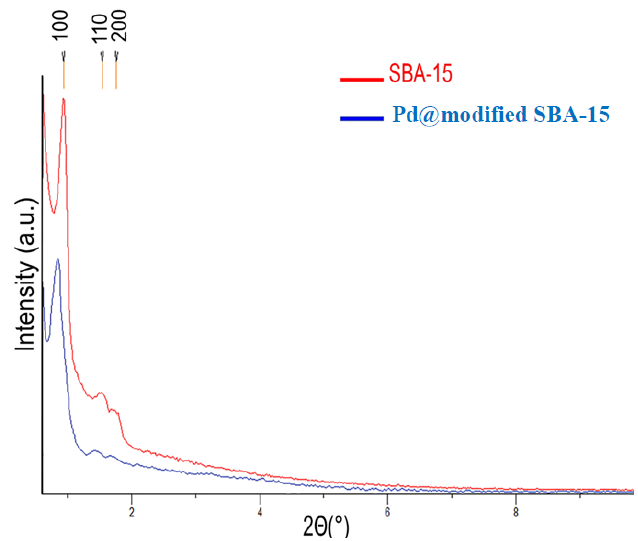
Fig. 2. The XRD pattern of SBA-15 and Pd@modified Figure 2 : The XRD pattern of SBA-15 and Pd@modified SBA-15